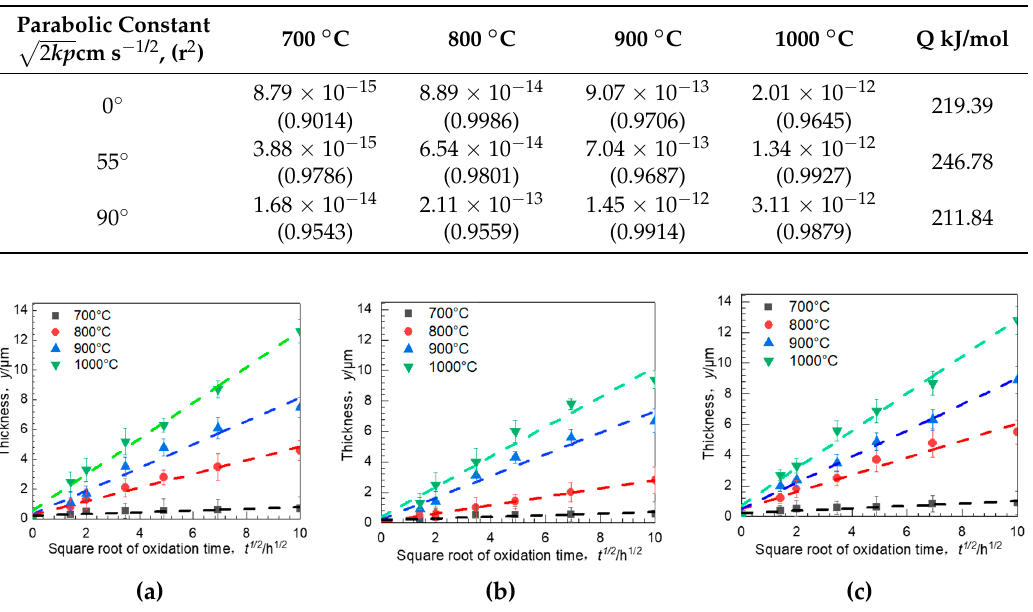
Table 3. Square root of parabolic rate constant, correlation coefficient, and activation energy of EBM-In718 alloys.